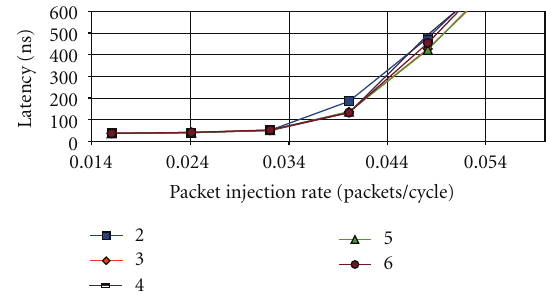
Figure 10: Latency as number of virtual channels is varied for hp .